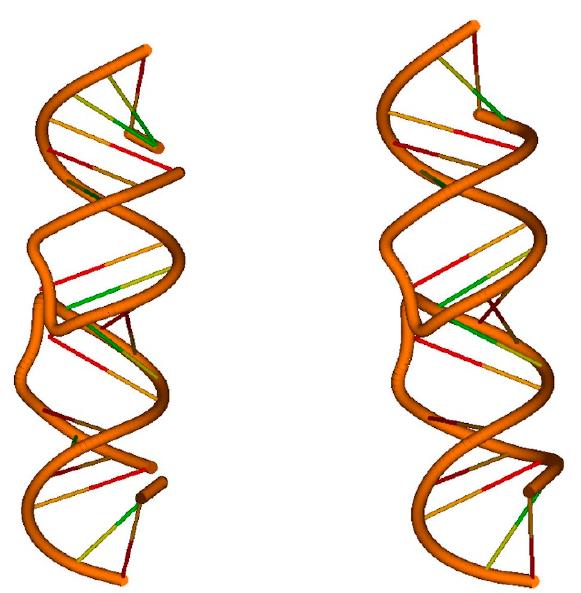
Figure 1. 2fd0: the CAB model on the left, the published model on the right.